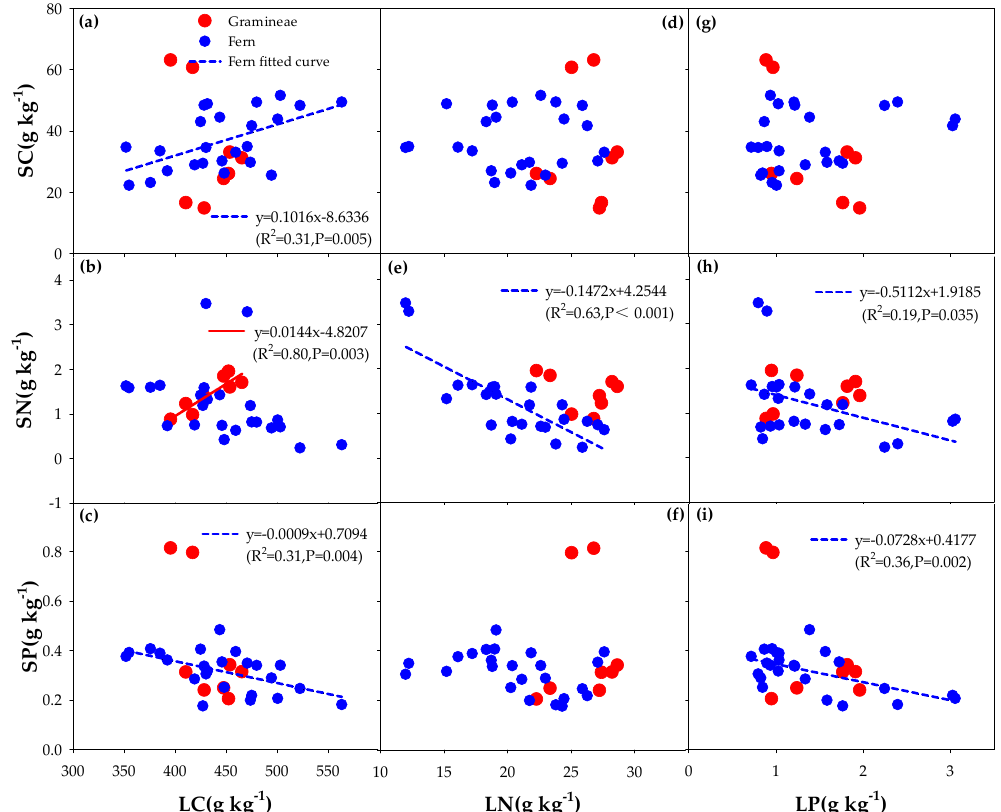
Figure 1. Correlations between litter and soil carbon, nitrogen, and phosphorus (C, N, and P) of four dominate species with two different functional types (Gramineae Lophatherum gracile and fern Woodwardia japonica , Dryopteris atrata and Dicranopteris dichotoma ) with N (100 kg ha − 1 year − 1 ) and P (50 kg ha − 1 year − 1 ) addition.